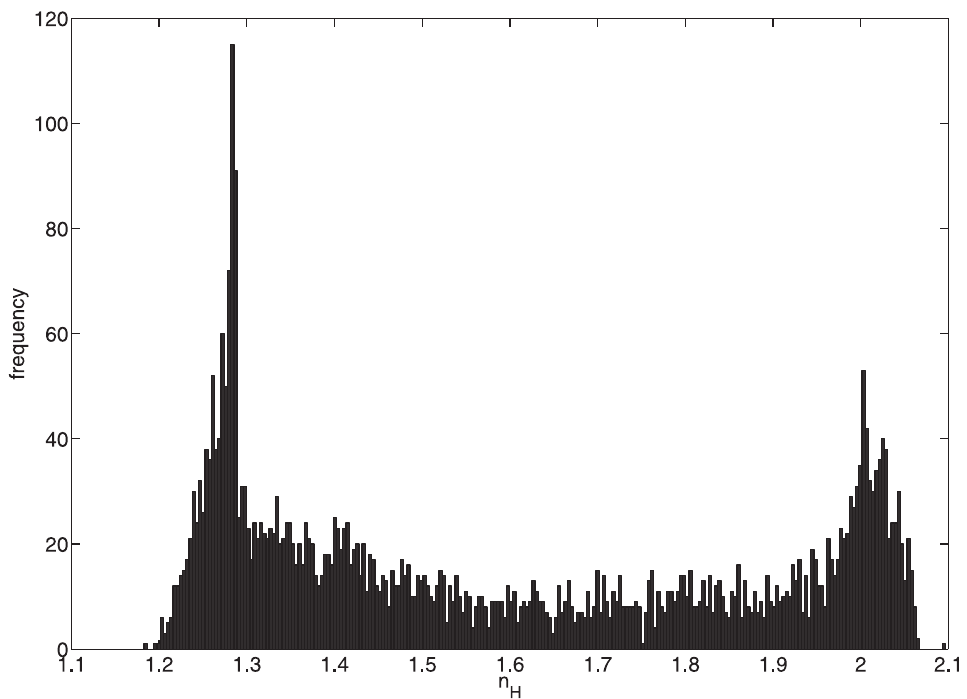
Figure 5. Distribution of Hill coefficients of model 2 given binding constants ( k on , k off ) with uniform log distributions.